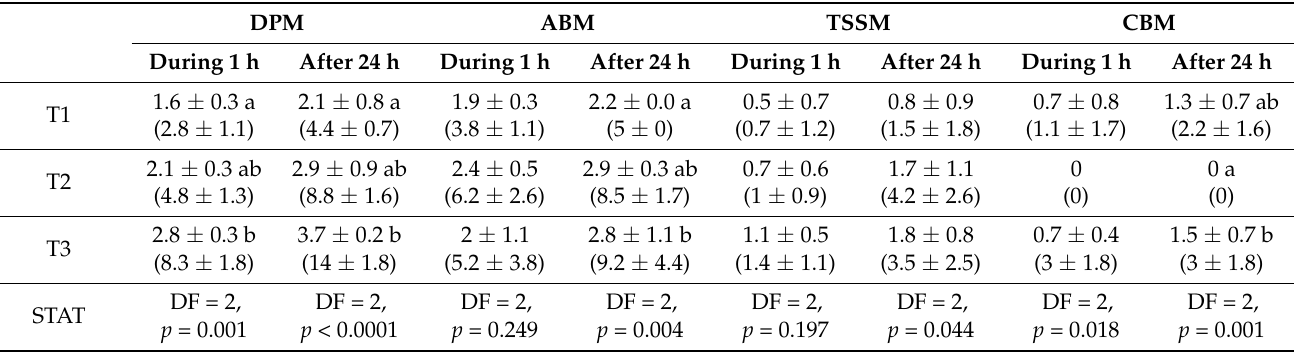
Table 3. Comparison of prey consumed by the predator S . gilvifrons for each pest species in three treatments during 1st hour of observation and after 24 h (parentheses represent mean ± std.dev of untransformed prey number consumed).